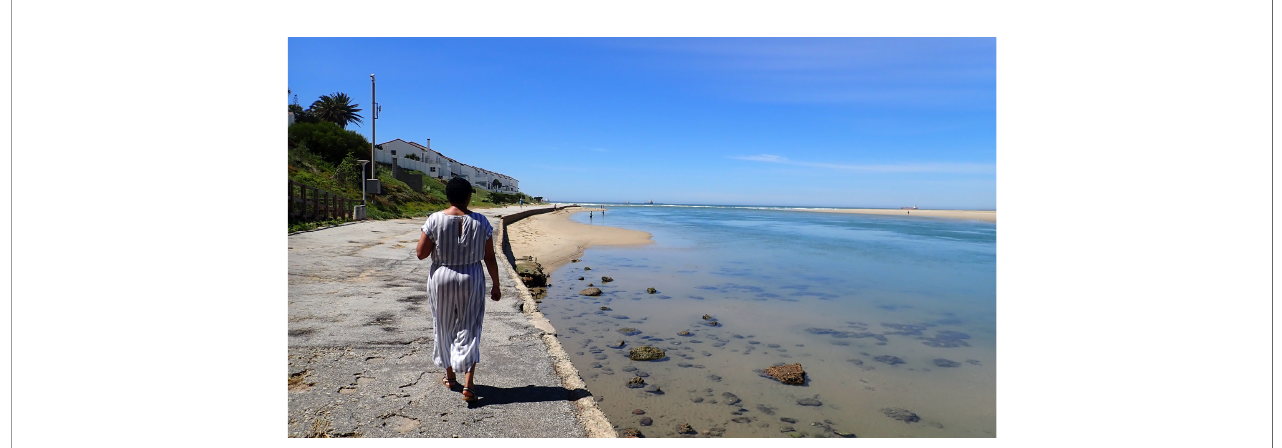
FIGURE 12 | Delene Spandiel walking along Bluewater Bay, where she used to come with her family when she was